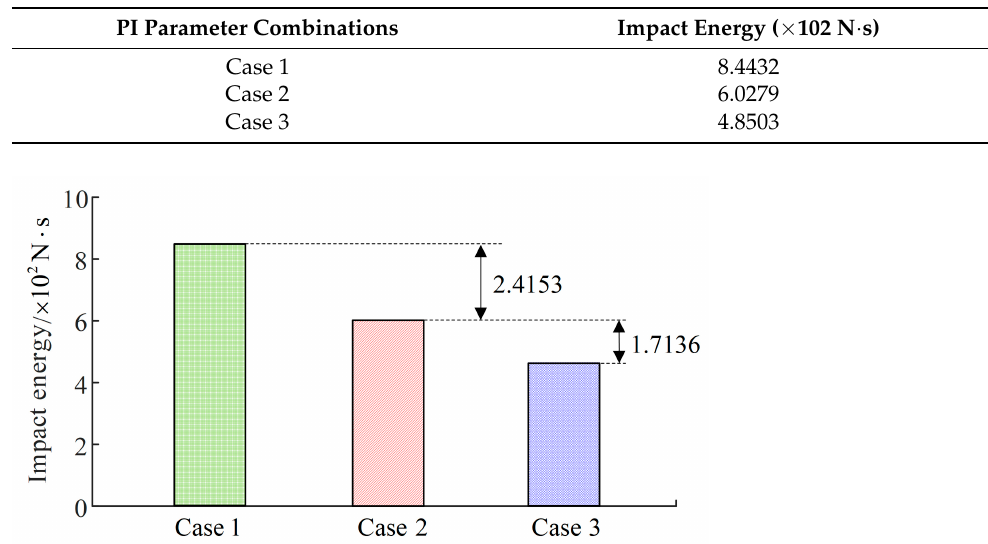
Table 8. Calculation results of the impact energy of the transmission system with different PI parameters.